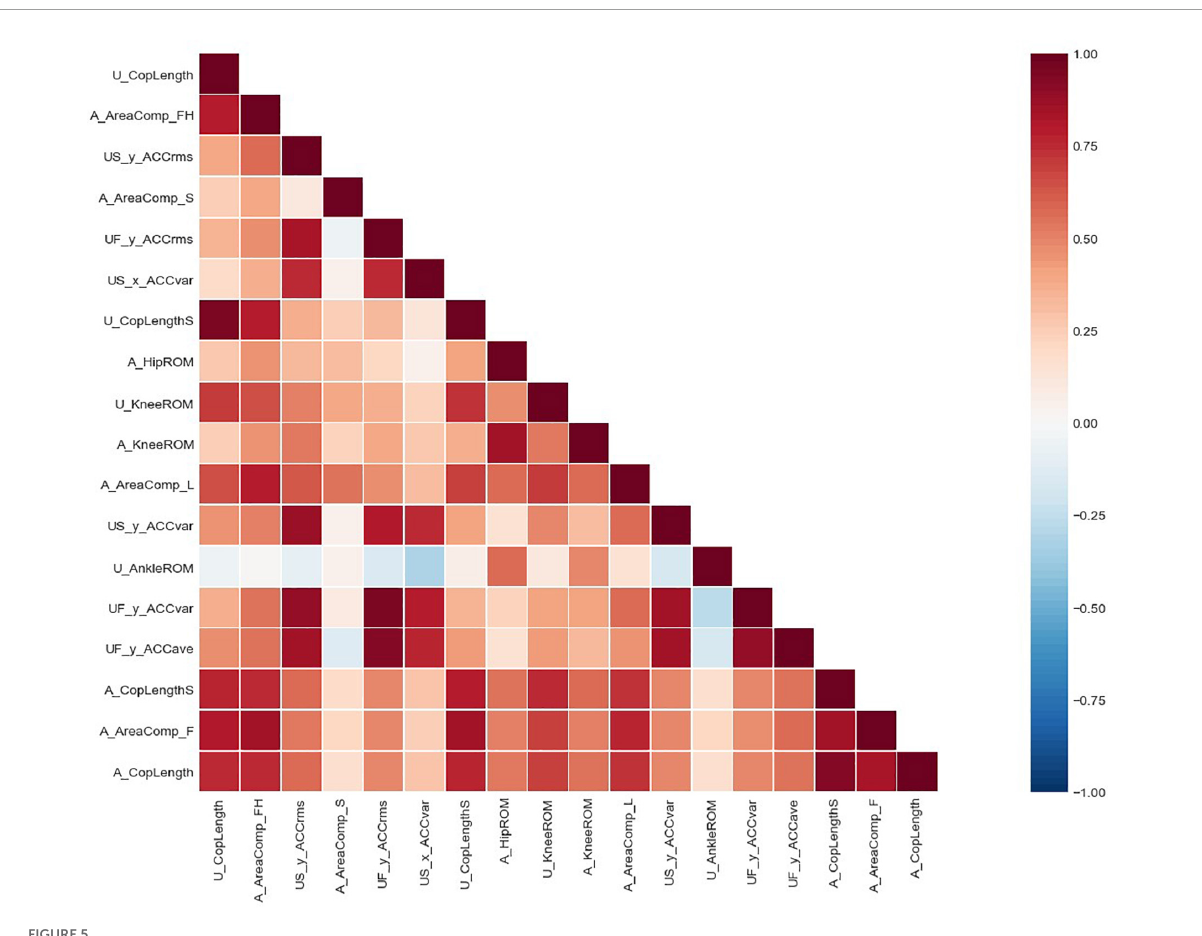
FIGURE5 Correlation matrix of top 18 most important